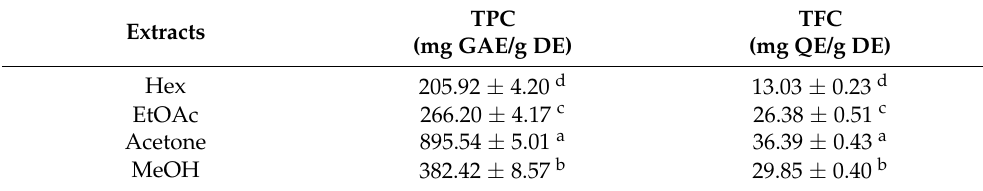
Table 2. Total phenolic and total flavonoid contents in Erodium arborescens aerial part extracts.